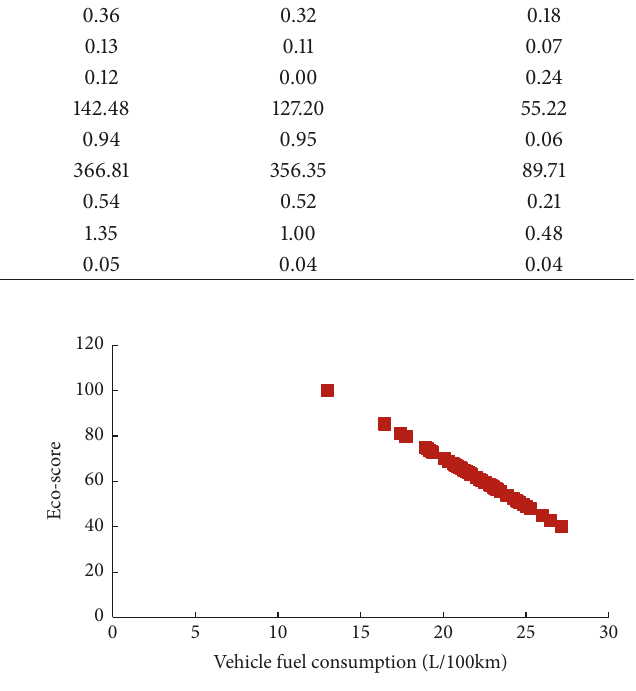
Figure 3: Relationship between fuel consumption and ecoscore during vehicle starting